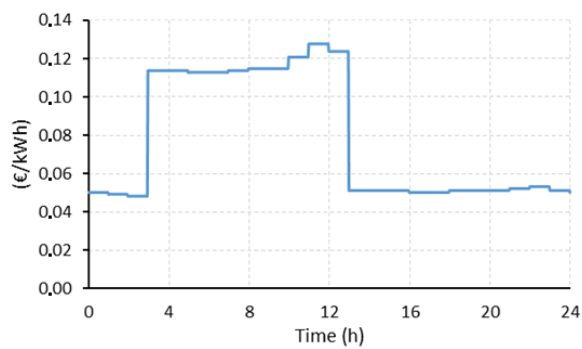
Figure 10. Energy cost